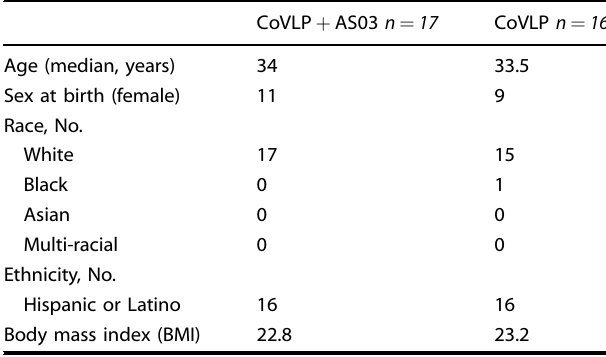
Table 1. Characteristics of vaccinated